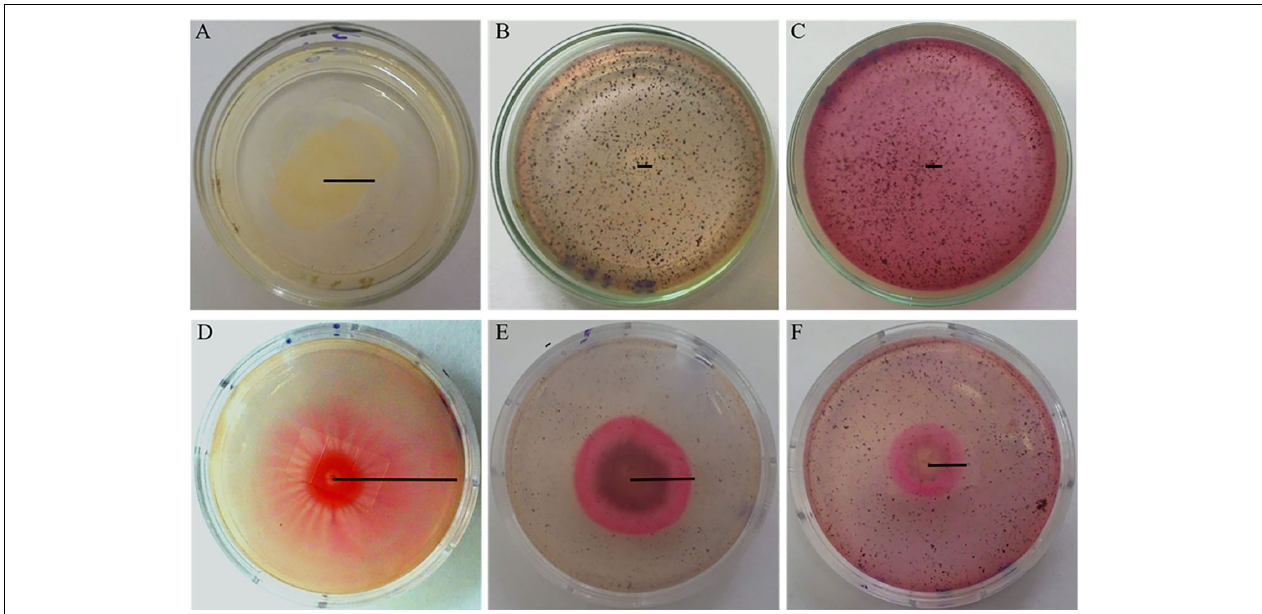
FIGURE 1 | Swarming motility of A. hydrophila (A–C) and S. marcescens (D–F) in semi-solid LB agar 0.5% (w/v) without phenolic extract (A,D) and with addition of 0.19 (B,E) and 0.39 mg GAE/g (C,F) of pulp phenolic extract of S. cumini (L.) Skeels. Black line indicates the radius of the colony.